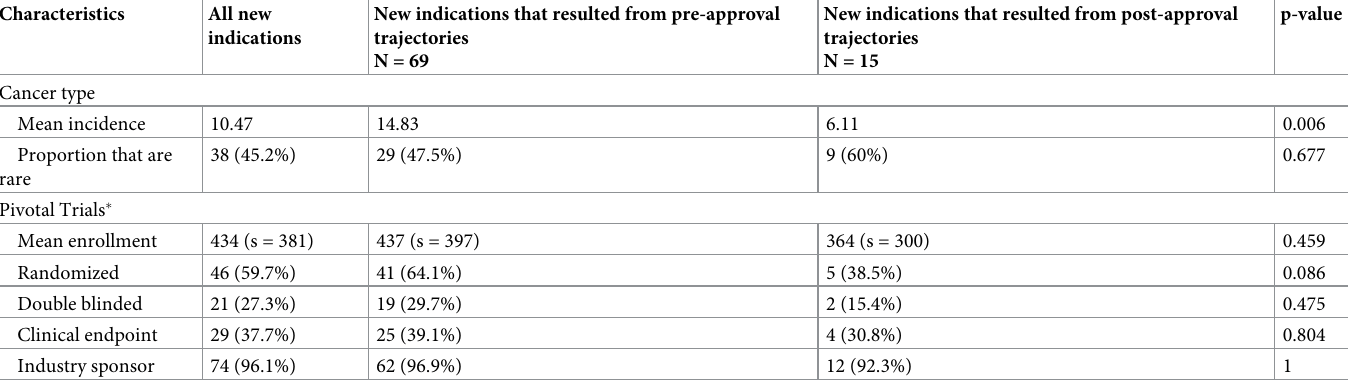
Table 1. Characteristics of the cancers and pivotal trials for secondary approvals resulting from pre-approval compared to post-approval trajectories.